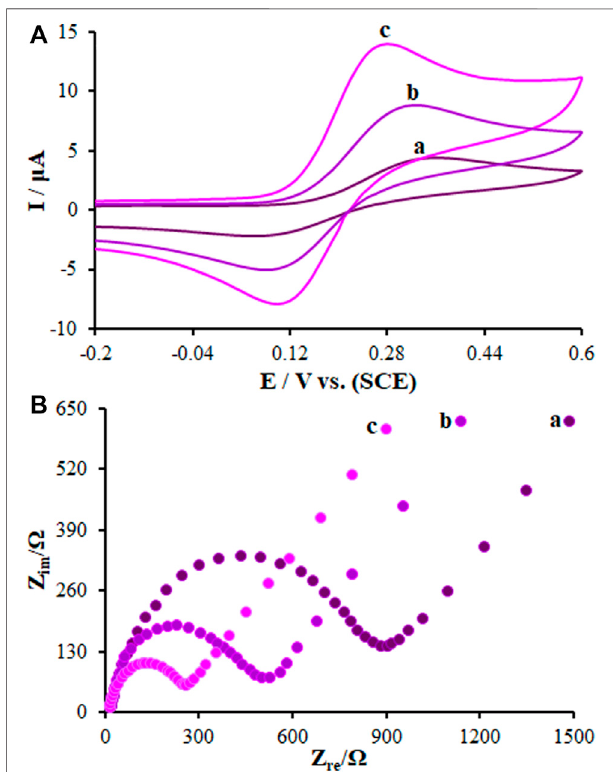
FIGURE 5 | (A) CVs of (a) BGCE, (b) SF-L Cu 2 S/GCE, and (c) La 2 O 3 @ SF-L Cu 2 S/GCE in the presence of 0.4 mM [Fe(CN)6] 3- solution in aqueous 0.1 M KCl. (B) EIS diagrams for 0.1 mM [Fe(CN)6] 3- solution at (a) BGCE, (b) SF-LCu 2 S/GCE,and(c)La 2 O 3 @SF-LCu 2 S/GCEinaqueous0.1 MKCl. Frequency range 100 KHz to 0.1